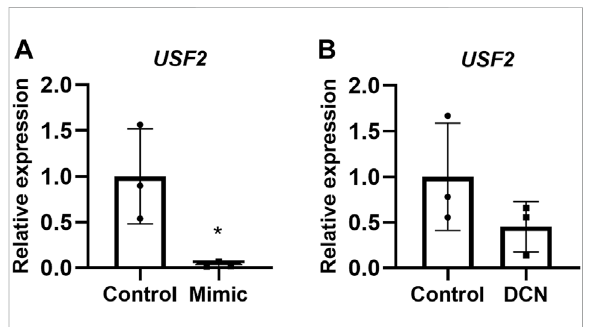
FIGURE 5 USF2 transcription factor may act as an intermediary for PPP3R1 upregulation by miR-512-3p in HTR-8/SVneo trophoblast cells. qRT-PCR showing USF2 upregulation in overexpressing miR-512-3p cells (A) and in exogenous DCN treated HTR-8/ SV neo cells for 24 h (B) analyzed using Student ’ s t-test (* p < 0.05, n = 3).